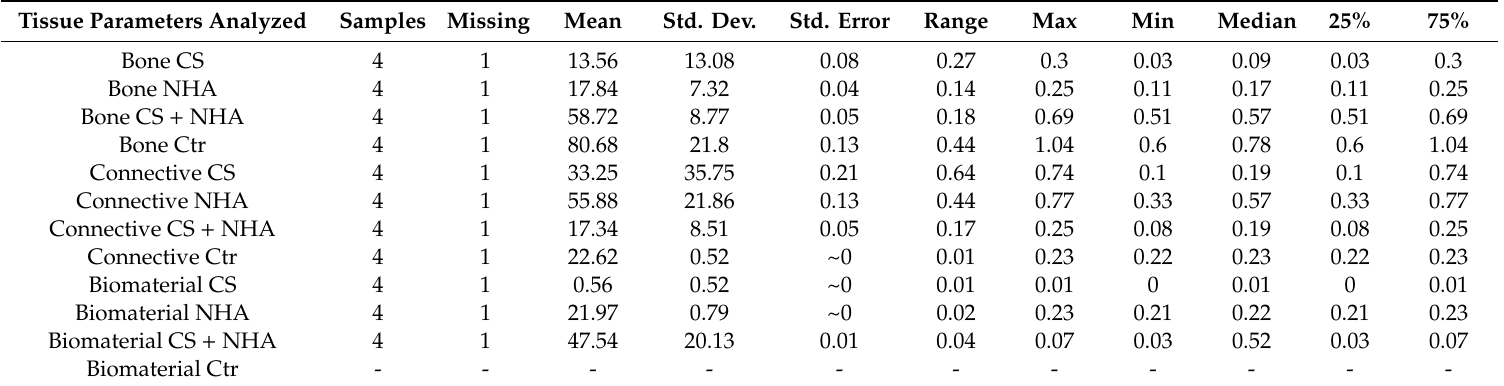
Table 3. Histomorphometric results in percentage